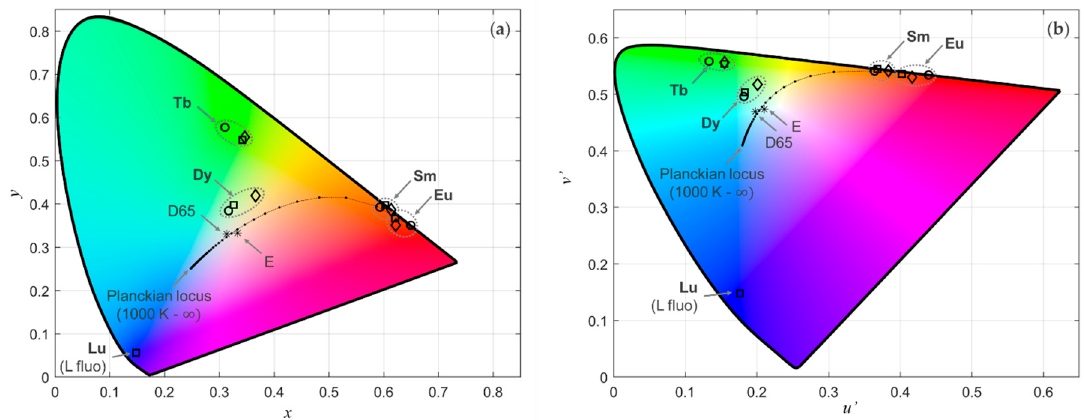
Figure 2. Chromaticity diagrams CIE-xy ( a ) and CIE 1976 UCS ( b ) of the 3 series of Ln complexes (circle = dipic, square = L c2 , diamond = do3a) with the blue fluorescent colours of [Lu 2 (L c2 ) 3 ], D65 and E illuminants and the Planckian locus showing the colours of black body radiations from 1000 K to ∞ .